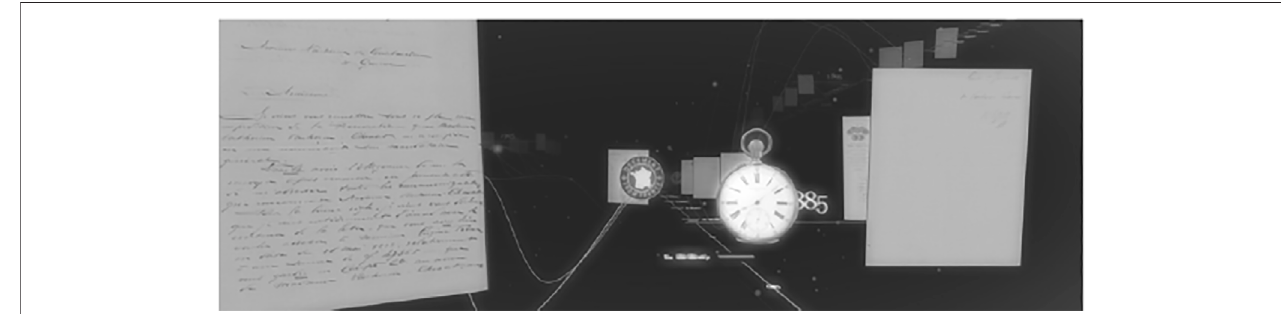
FIGURE 3 | VR archives of a watch-manufacturer used for the memorization task.